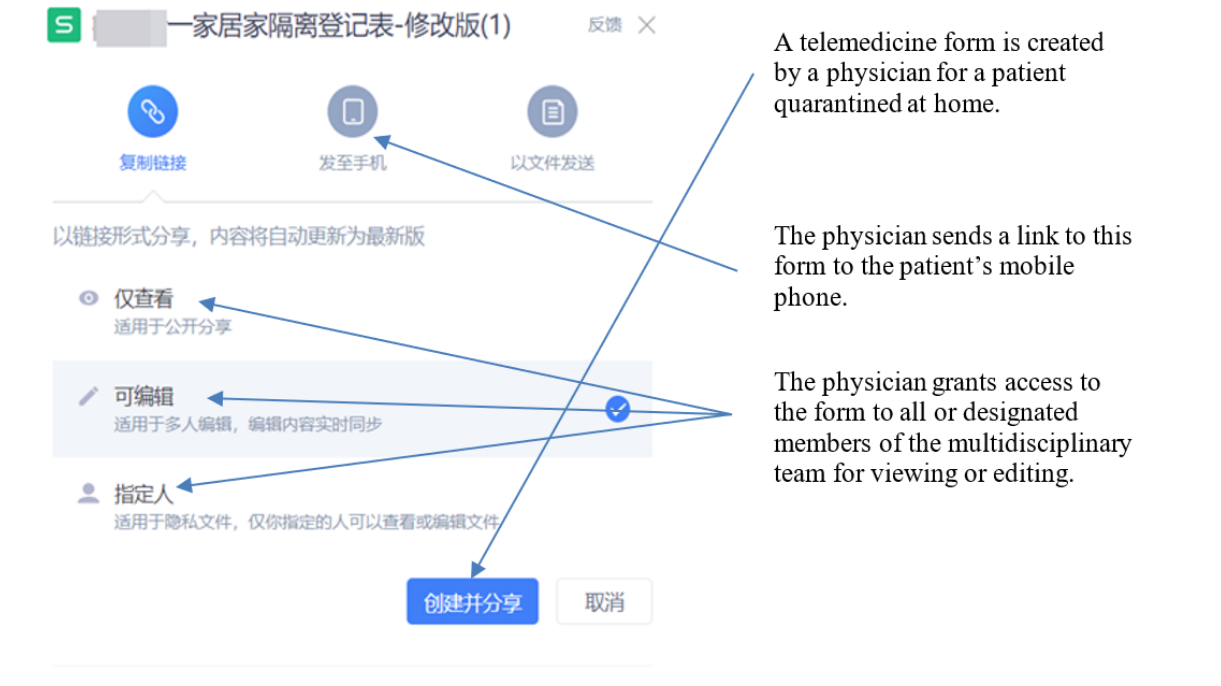
Figure 3. Screenshot of the creation of the telemedicine form by the multidisciplinary team (in Chinese, with English